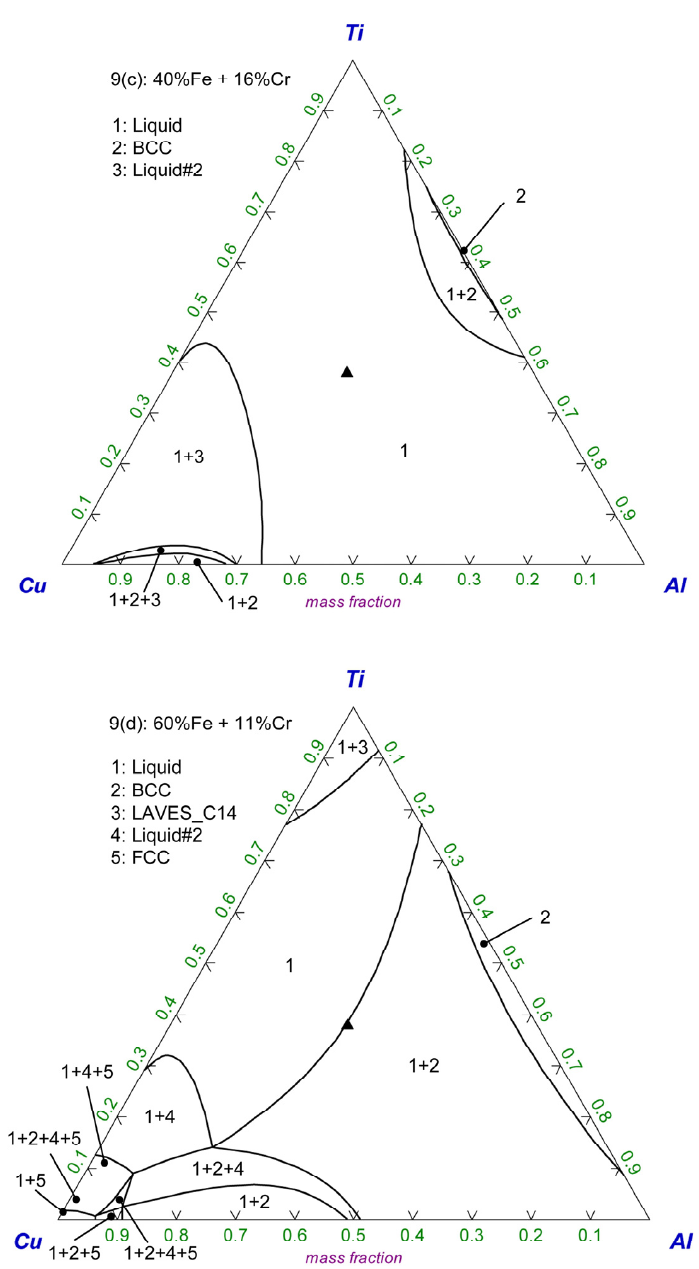
Figure 9. ( a – d ) Cu-Al-Ti-Cr-Fe pseudo ternary phase diagrams for 1300 °C at increased %Fe, as calculated in FactSage 7.3 [33].